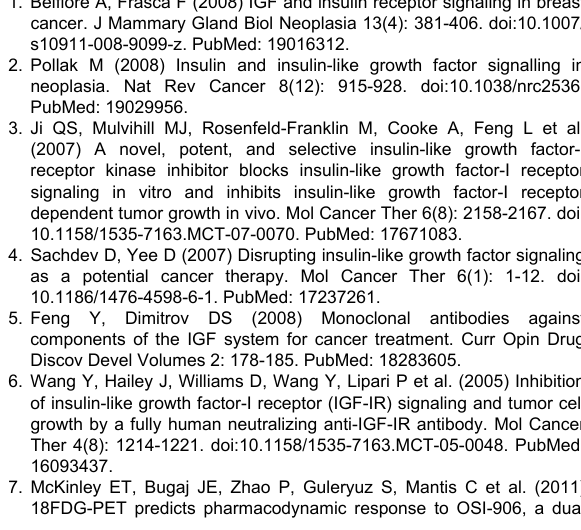
Figure S3. Effects of stimulation of Mock-transfected cells with insulin and IGF-I on cell invasion. (A) Representative images of cell invasion through Matrigel using 8 mm pore of a polycarbonate membrane. Nuclei were stained with DAPI. No significant differences were observed on cellular invasion upon insulin and IGF-I stimulation of mock-transfected cells. (B) The bar graph shows the amount of cells/field. Effects of stimulation with insulin and IGF-I on the fibronectin protein and mRNA expression levels, respectively . (C) and